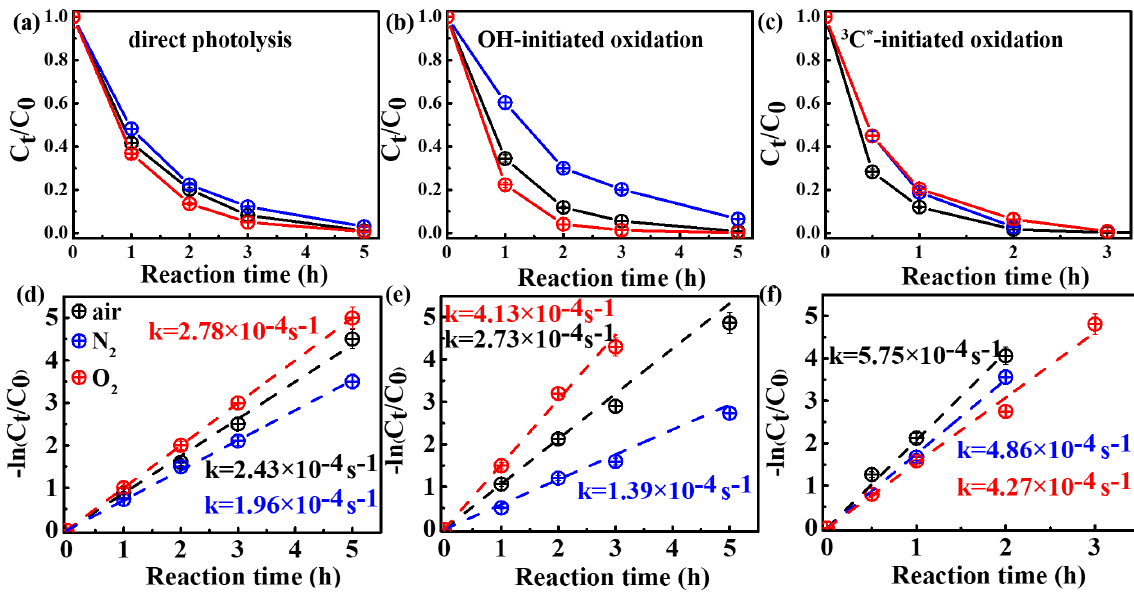
Figure 3. Ratio of unreacted eugenol concentration to its initial concentration ( C t /C 0 ) as a function of reaction time at different saturated gases under (a) direct photolysis (b) OH-initiated oxidation and (c) 3 C ∗ -initiated oxidation. Rate constants of panels (a) – (c) are presented in panels (d) – (f) correspondingly.